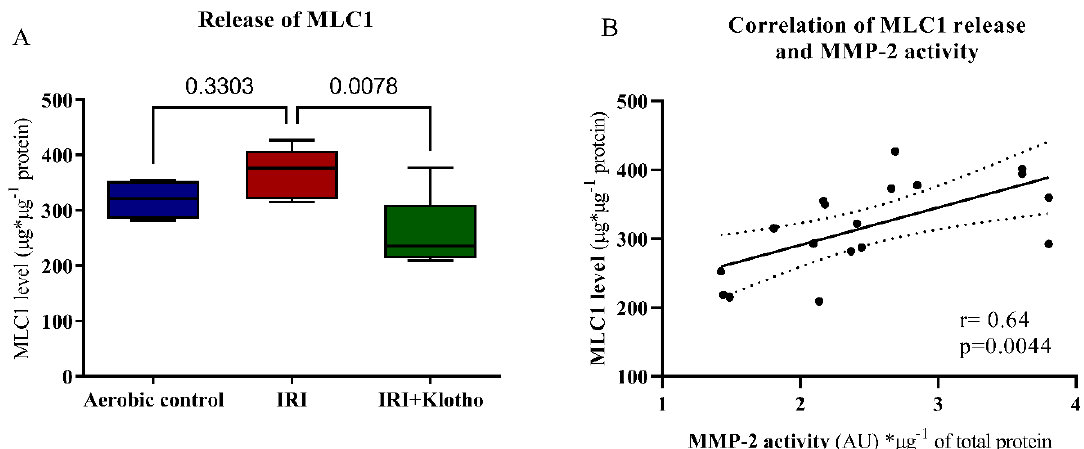
Figure 5. ( A ) The concentration of MLC1 in cell supernatants (S1) was tested by ELISA and normal-